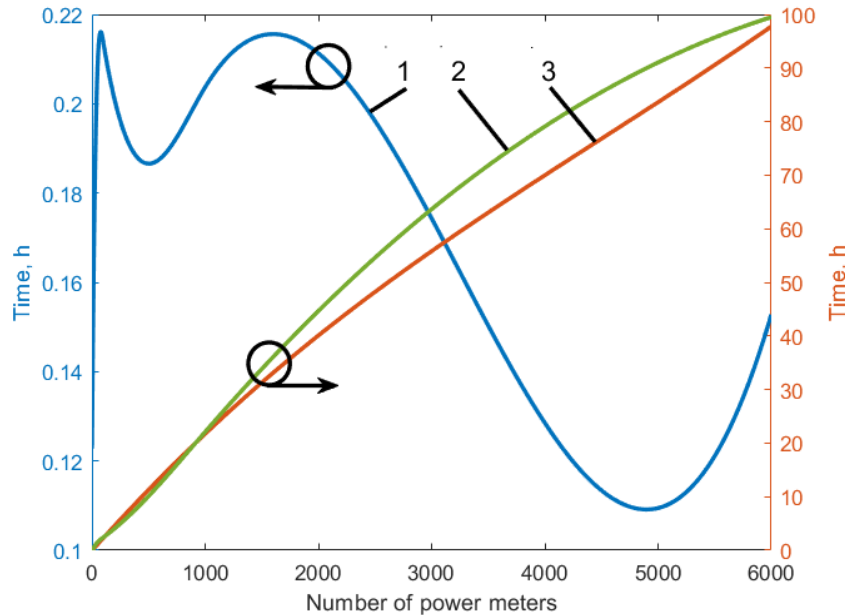
Figure 9. The produced artificial data traffic, when 10 GB data stream was produced and repeatedly broadcast during the trial, when 1—transmission time of one power meter, 2—transmission time of all power meters selected, 3—receiver time in system of all power meters selected. Black circles shows y